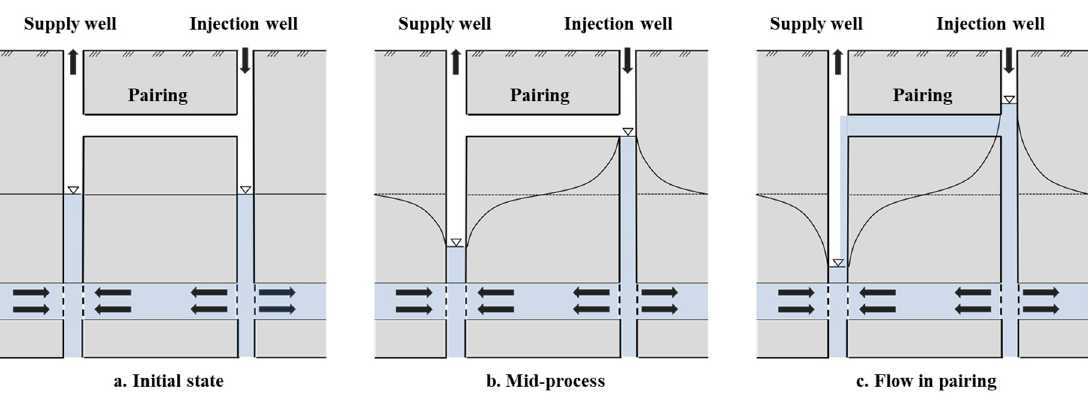
Figure 1. Groundwater level change during system operation (without pairing).